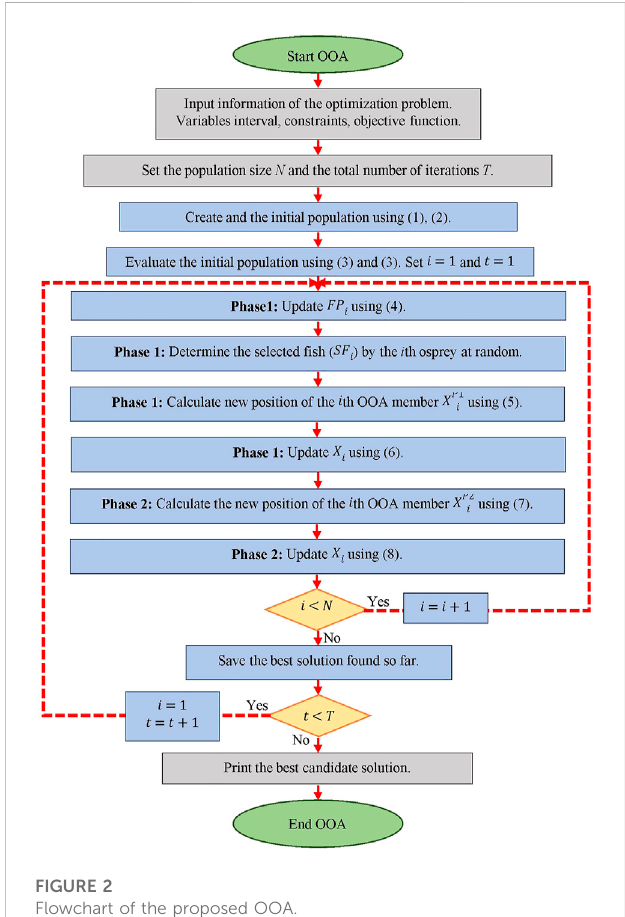
FIGURE 2 Flowchart of the proposed